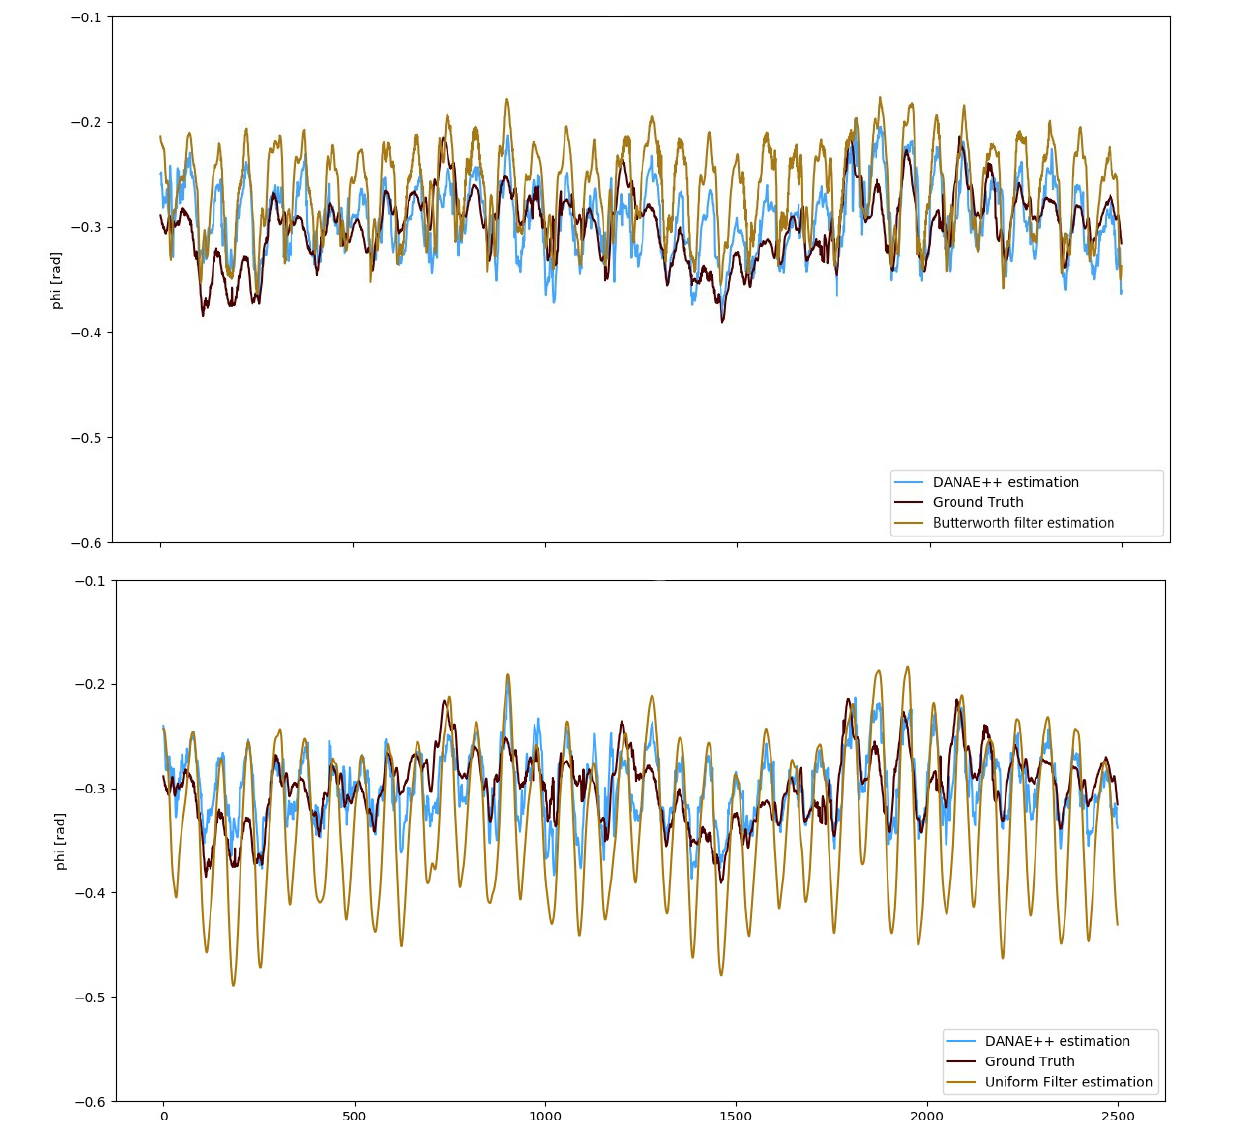
Figure 7. OxIO Dataset: roll angle estimation provided by DANAE ++ (light blue) compared to the butterworth (top) and the uniform1d (bottom) filters applied on the EKF outputs (light brown). The GT (dark red) is reported as reference in both the